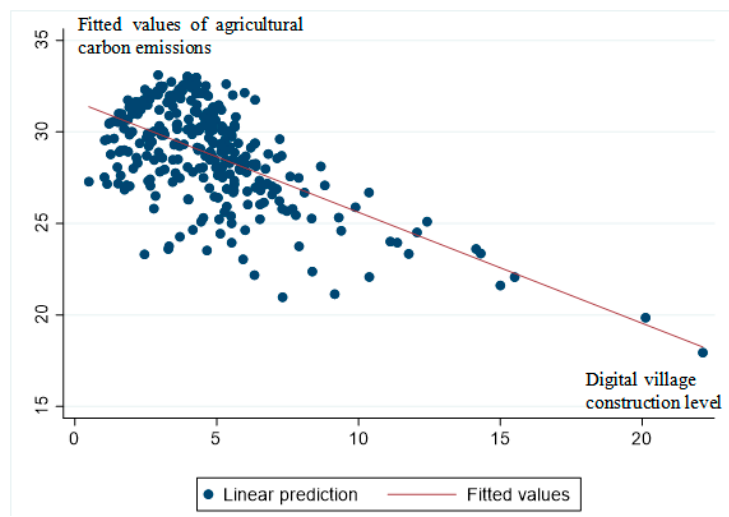
Figure 3. Fitted line